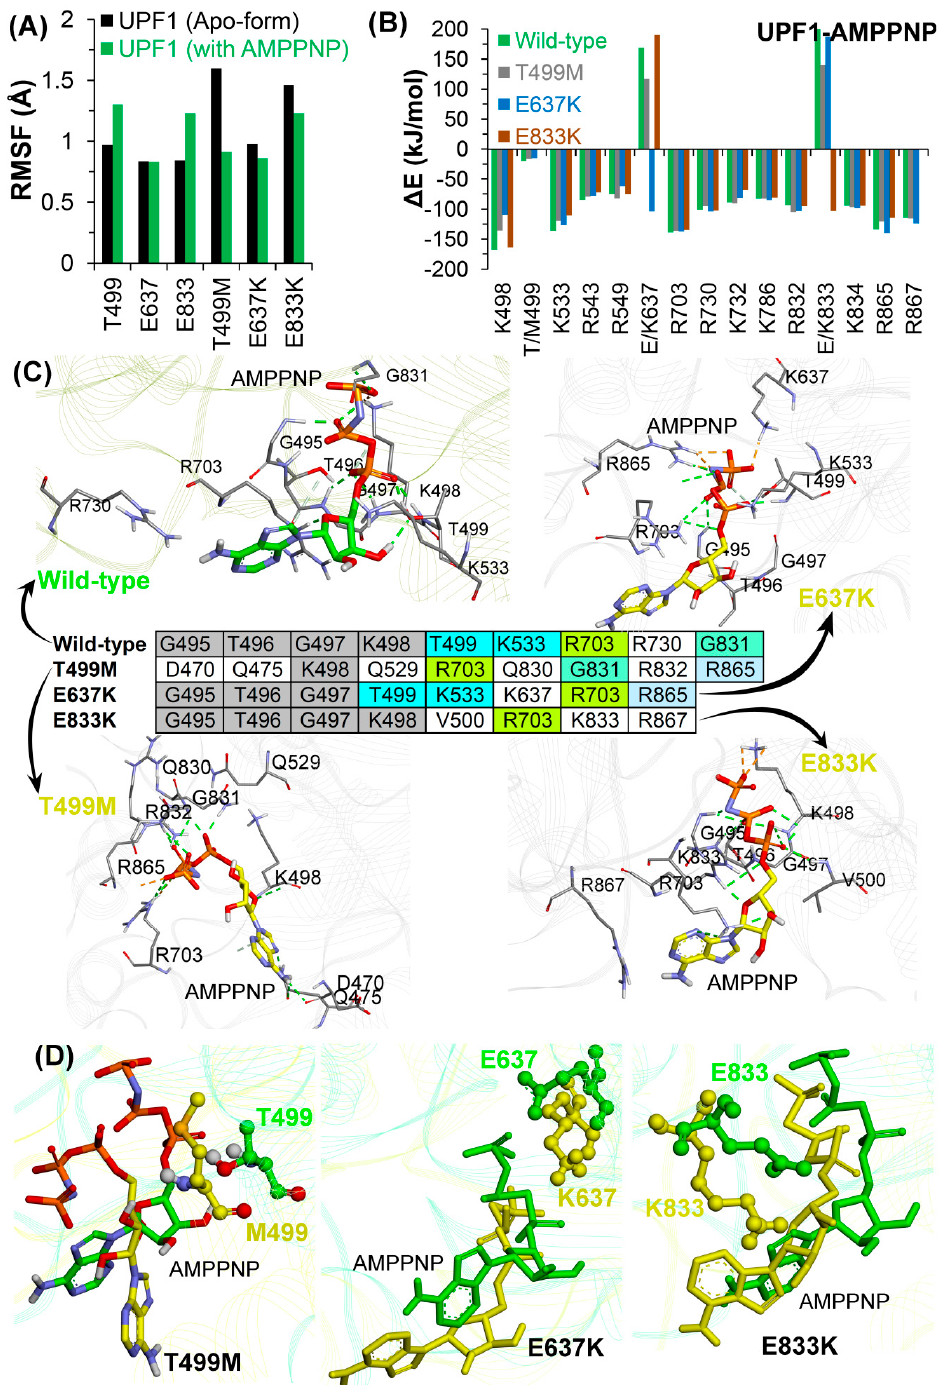
Figure 5. Molecular properties of the UPF1-AMPPNP model systems. ( A ) Substrate binding site residues of the UPF1 protein and studied mutations. RMSFs for wild-type UPF1, mutant models; apo-form and AMPPNP bound UPF1. ( B ) Individual residues of UPF1 contributing to the binding energy for AMPPNP, calculated by MM-PBSA. ( C ) Binding mode of AMPPNP to the UPF1 protein in different model systems, and UPF1 residues forming stable H-bonds with AMPPNP having occupancy ≥ 10%. ( D ) Binding conformation of AMPPNP with respect to the wild-type and mutated UPF1 (T499M, E637K, and E833K) obtained from the end of